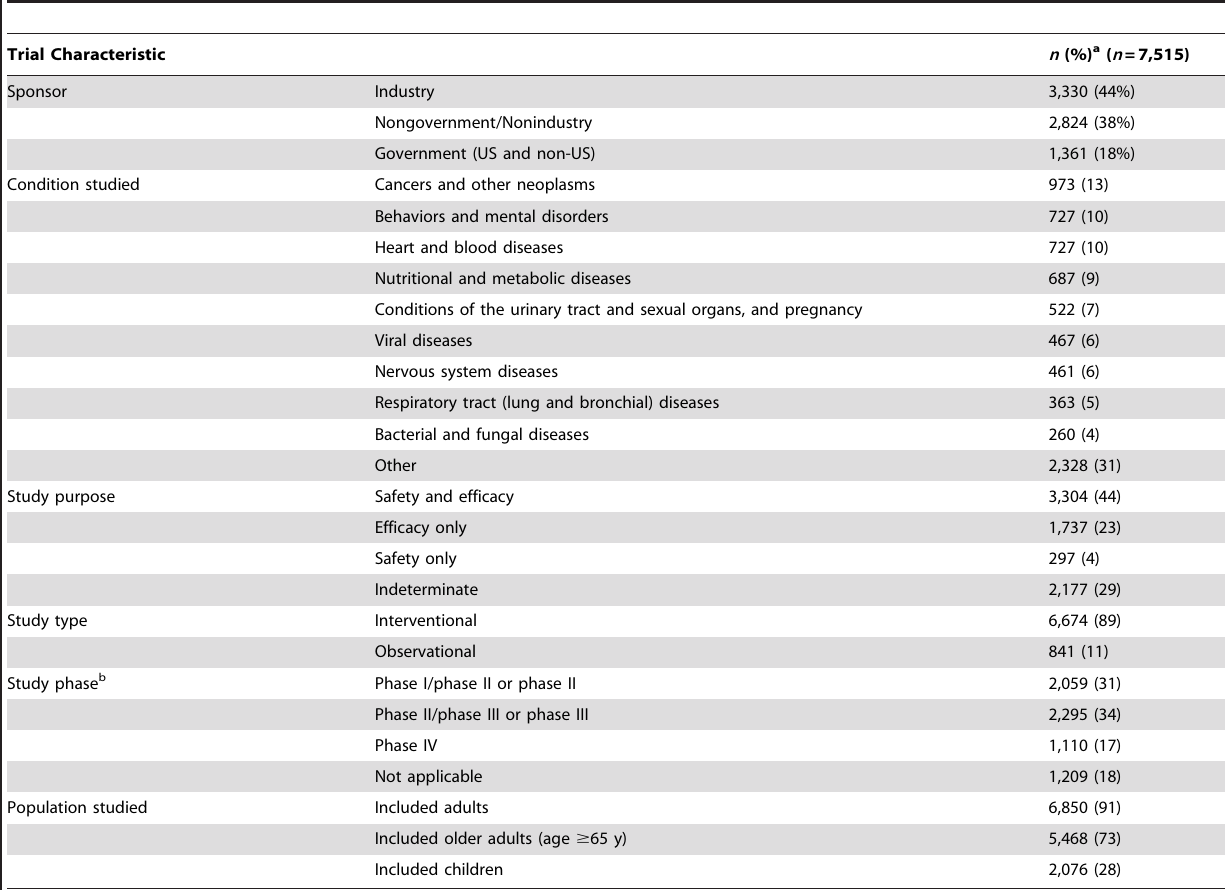
Table 1. Characteristics of completed trials registered in the ClinicalTrials.gov database after December 31, 1999 (excluding phase I